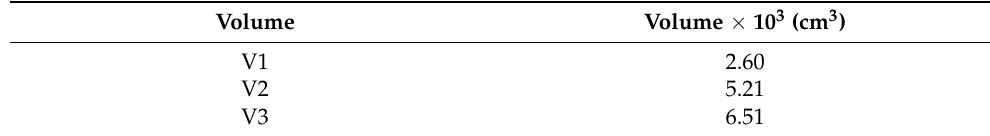
Figure 1. 3D schematic of the SDBD plasma source used in the experimental activities: ( a ) exploded and ( b ) assembled views of the plasma source Table 1. Available treatment volumes defined using different PMMA fillings.